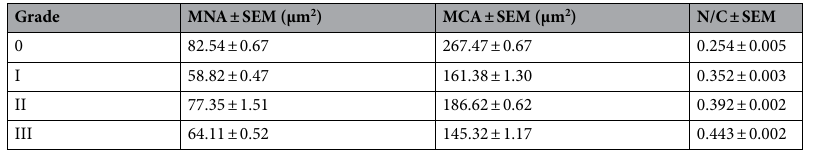
Table 1. Tumor cell characteristics in tissue sections via THG imaging. N = 150 cells for each grade. N/C ratio of cancerous tissues (Grade I–III) appear to have statistically significant difference (p < 0.0001****) respectively